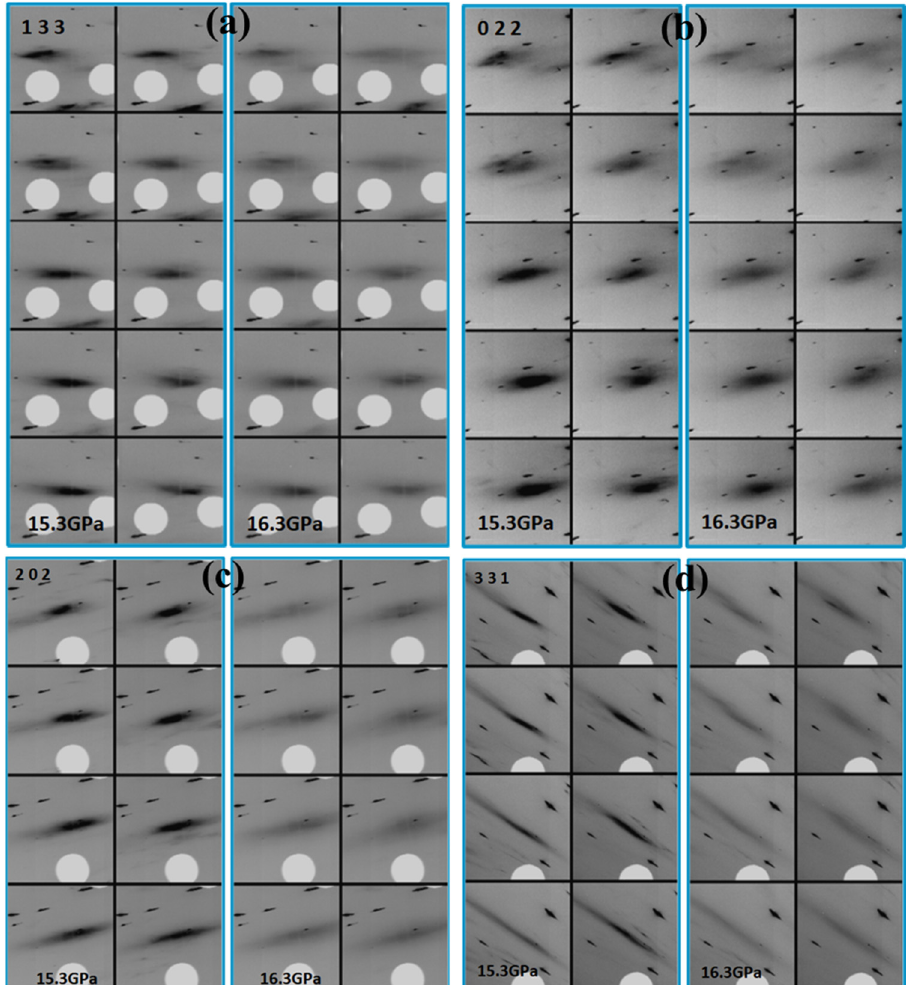
Figure 7. Maps of Laue reflections from crystal 1 ( a , b ) and crystal 2 ( c , d ) showing pressure-induced broadening. The intensity scaling is same as defined in Fit2d program [54].